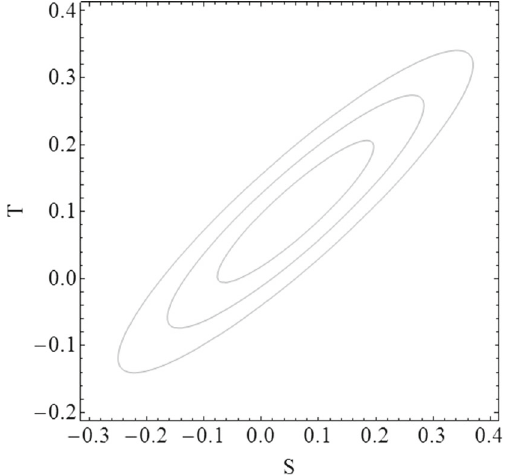
Fig. 1 Allowed values of S and T [46] at, from the innermost to the outermost ellipse, 68, 95.5 and 99.7% confidence level